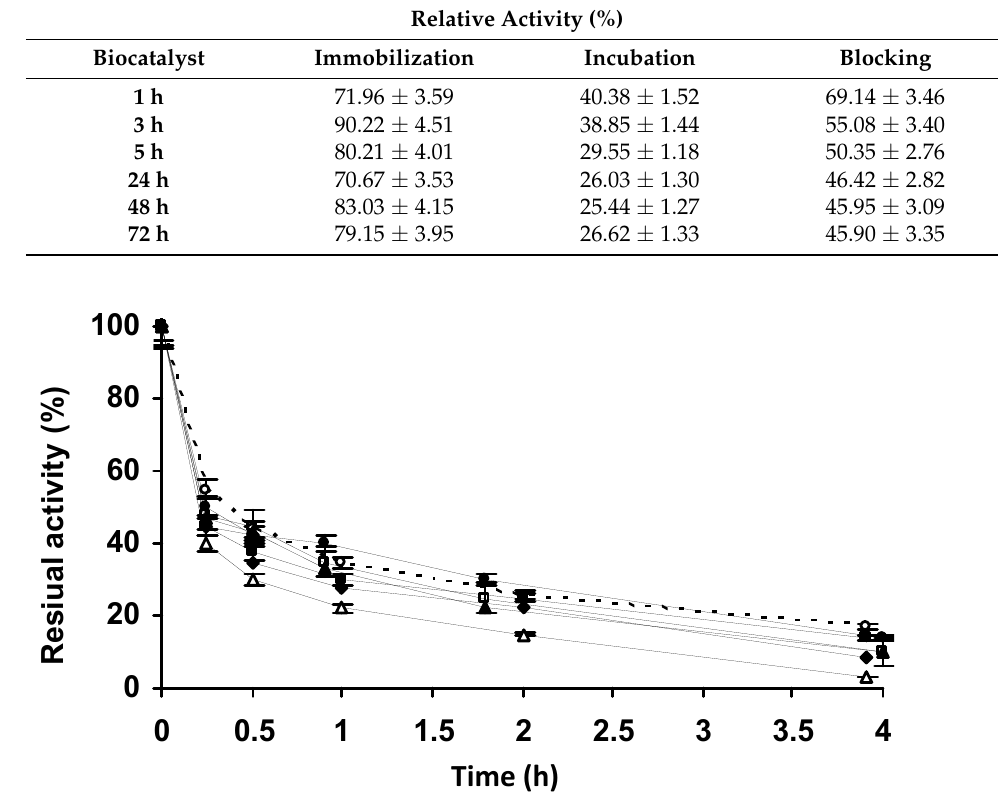
Figure 10. Thermal inactivation courses of PGA immobilized at pH 7 in 1 M sodium sulfate and incubated at pH 10 for different times compared to the enzyme immobilized on glyoxyl agarose The biocatalyst was blocked with 2 M glycine. Empty circles with dashed line: glyoxyl agarose. Empty triangles with solid line: 1 h. Full circles with solid line: 3 h. Full squares with solid line: 5 h. Empty squares with solid line: 24 h. Full rhombus with solid line: 48 h. Full triangles with solid line: 72 h. Other specifications are described in the